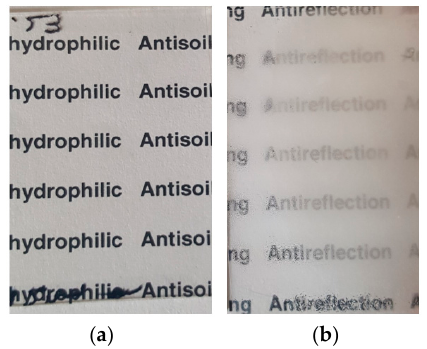
Figure 5. Antifogging results: ( a ) coated glass slide; ( b ) uncoated glass slide.